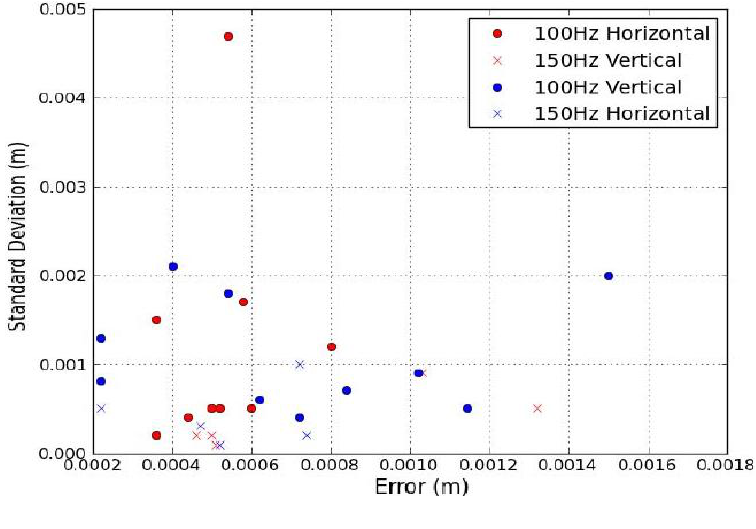
Figure 7. MIMIC’s profile spacing calculations: Calculating average error over five measurements plotted against measurement reliability ( σ ) for horizontal and vertical profile spacing at two mirror frequencies −100 Hz and 150